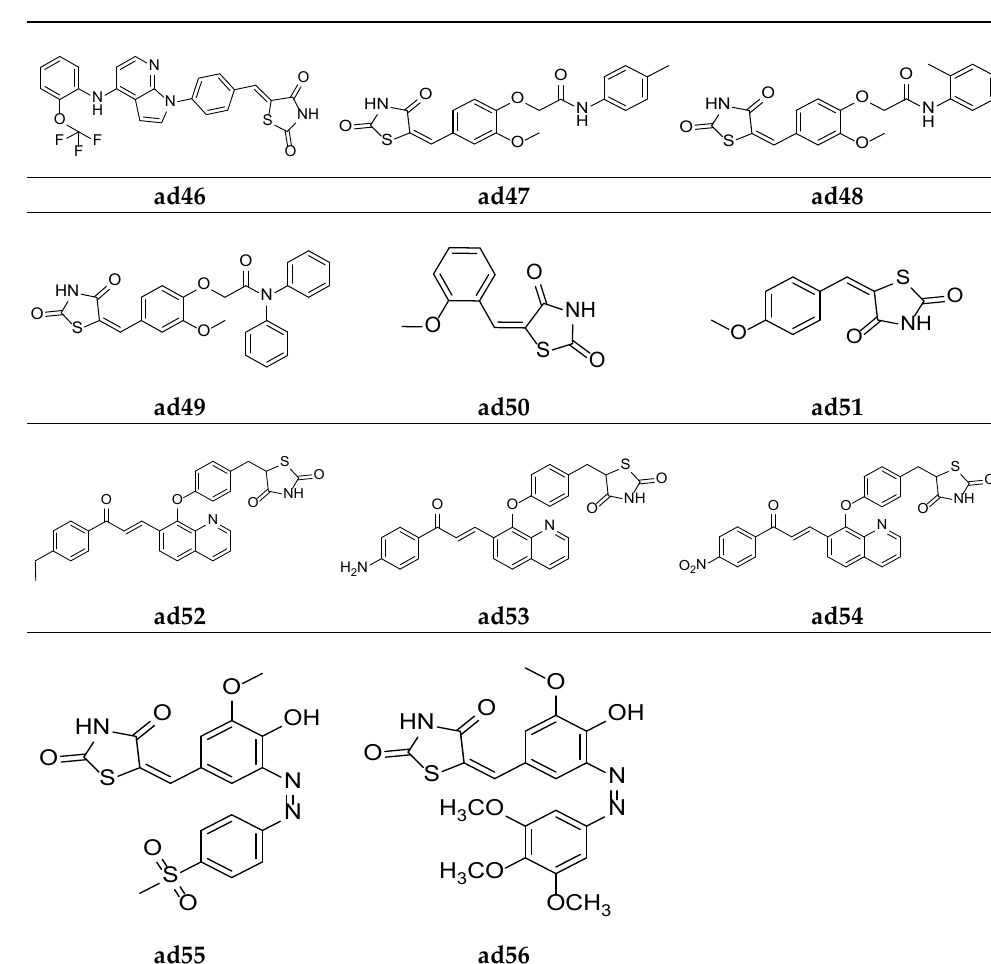
Figure 17. Molecular structures of the compounds ( ad46 – ad56 ). Table 50. Antidiabetic potential of the compounds ( ad47 – ad49 ) using an alloxan-induced model in rats.